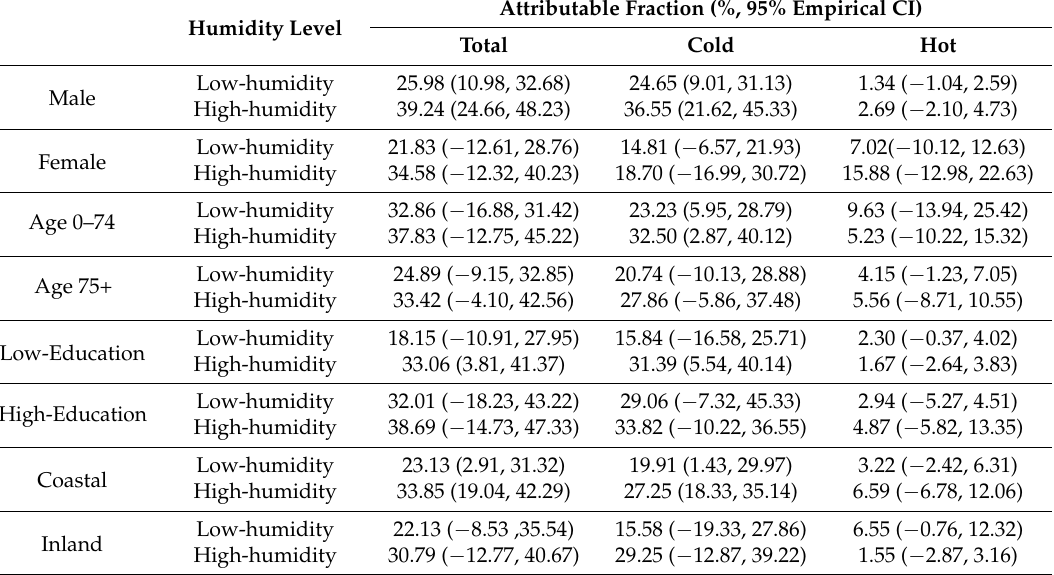
Table 4. The pooled attributable fractions of cold and hot effects on CVD mortality over lag 0–21 days at different levels of